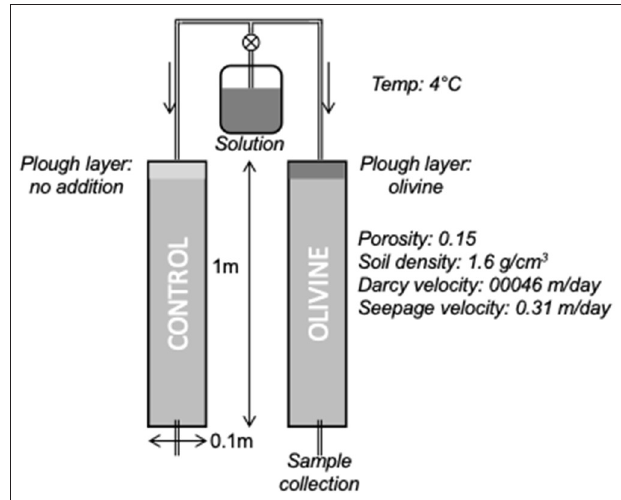
FIGURE 1 | Diagram of the soil column experiments. Adapted from Pogge von Strandmann et al. (2021b) and Renforth et al.